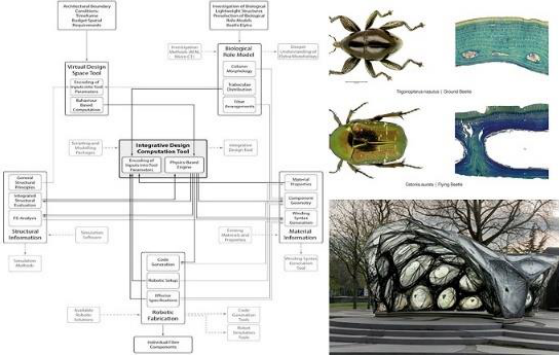
Figure 10. An example of biomimetic design, (ICD, n.d.).